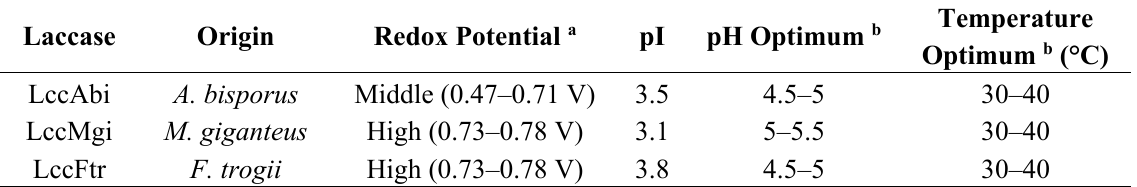
Table 1. Characteristics of laccases used for the degradation of acetyl curcumin.